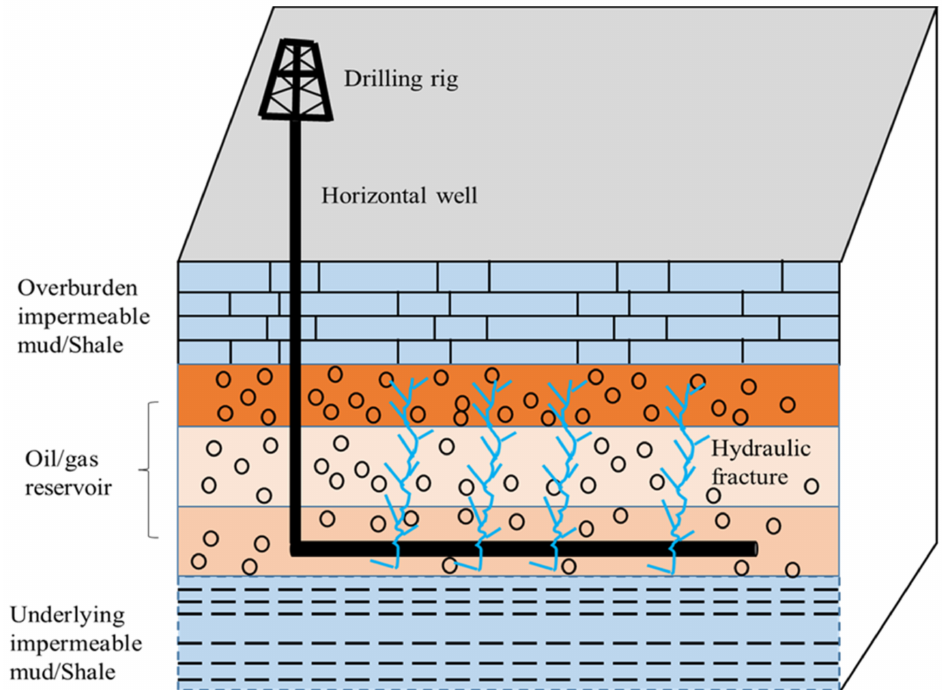
Figure 1. Schematic of a horizontal well with multistage hydraulically fracturing applied in a multilayered oil/gas